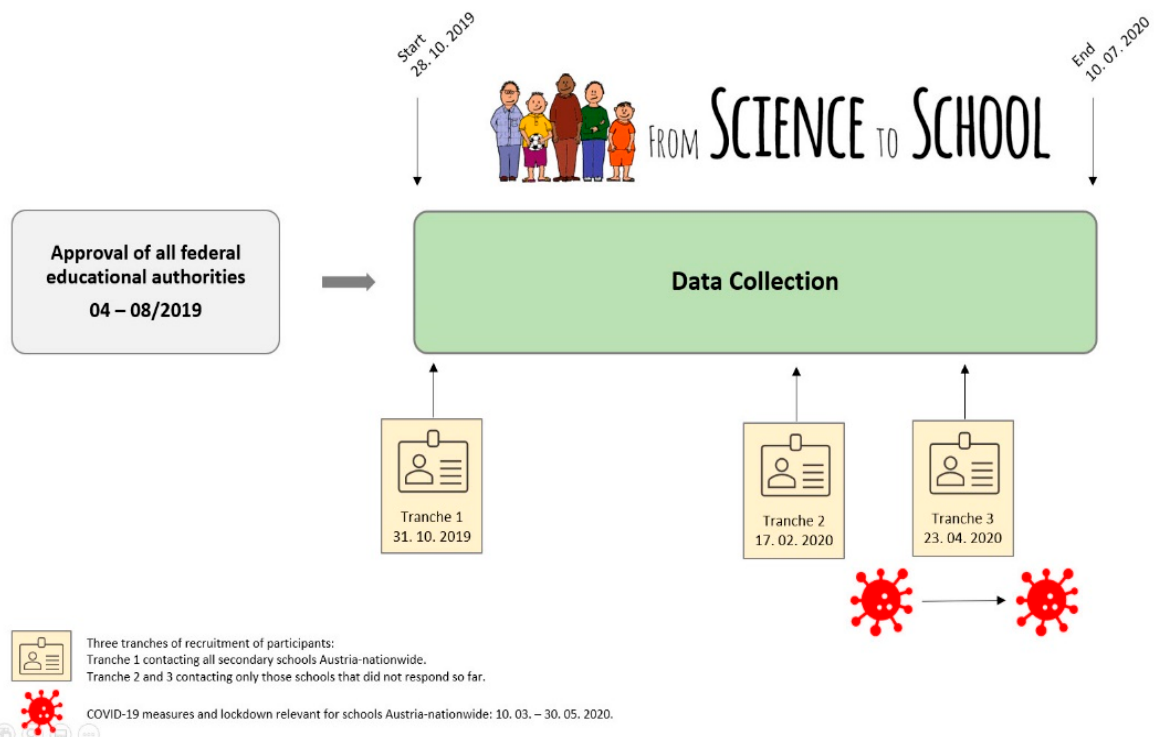
Figure 2. Flow chart of procedure and timescale of a previous application to approval of educational authorities and subsequent data collection by online survey.